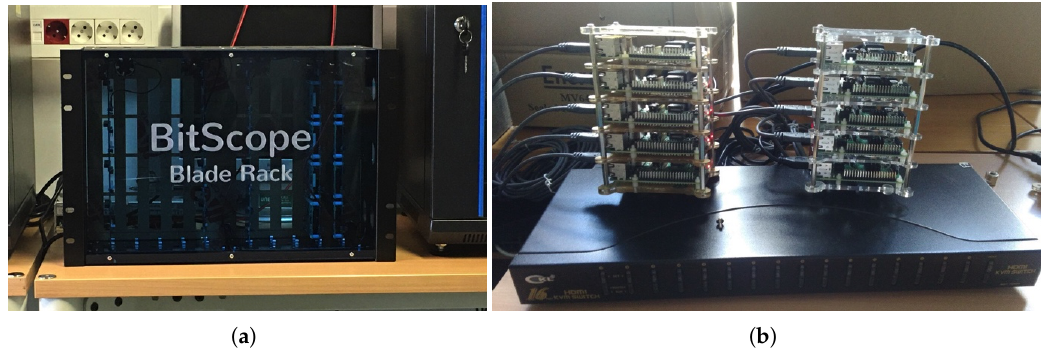
Figure 3. Devices clustering: blade rack and cheap setup. ( a ) Blade rack. ( b ) Cheap